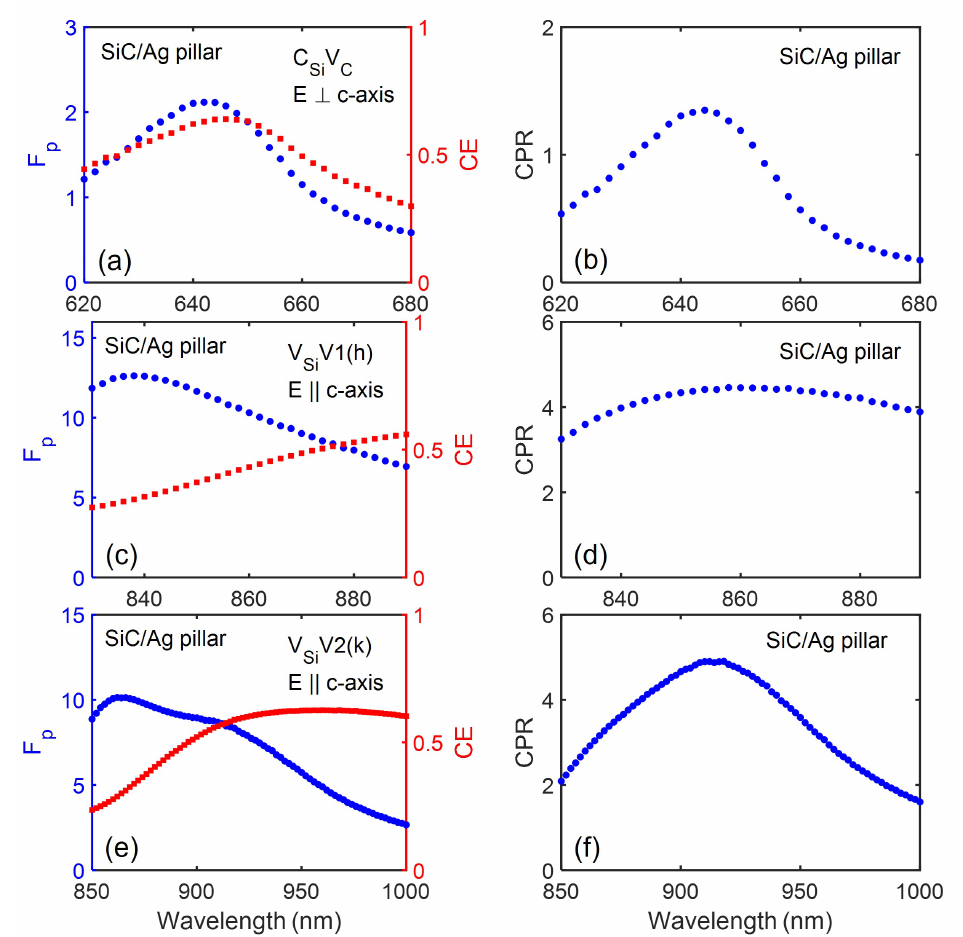
Figure 3. The modified Purcell factor, F p , ( a , c , e ) and collection efficiency, CE; the corresponding CPR performance for various point defect emitters in SiC pillar ( b , d , f ). The specified color centres dipole is located 20 nm below the Ag cylinder surface with the given polarisations. Table 2. The optimised parameters for the various studied color centres in 4H-SiC: the SiC/Ag cylinder diameter and Ag antenna